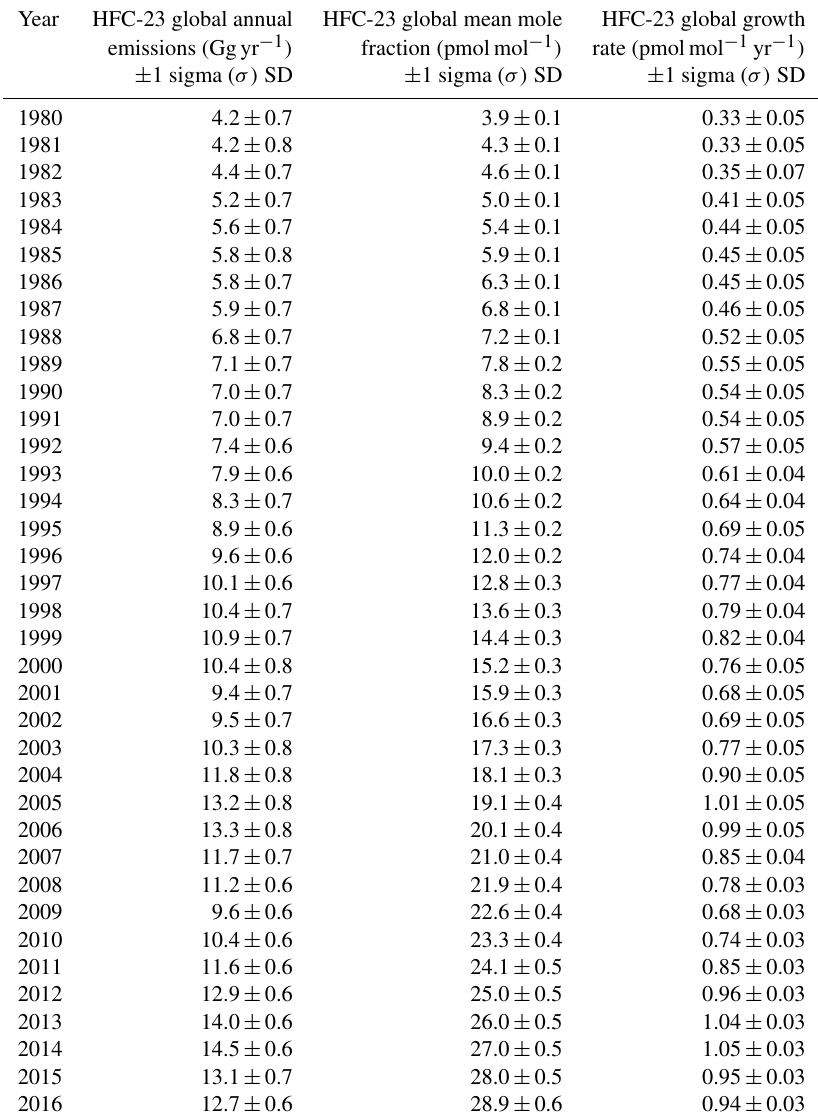
Table 2. Annual mean global HFC-23 emissions, mole fractions and growth rates, derived from the AGAGE 12-box